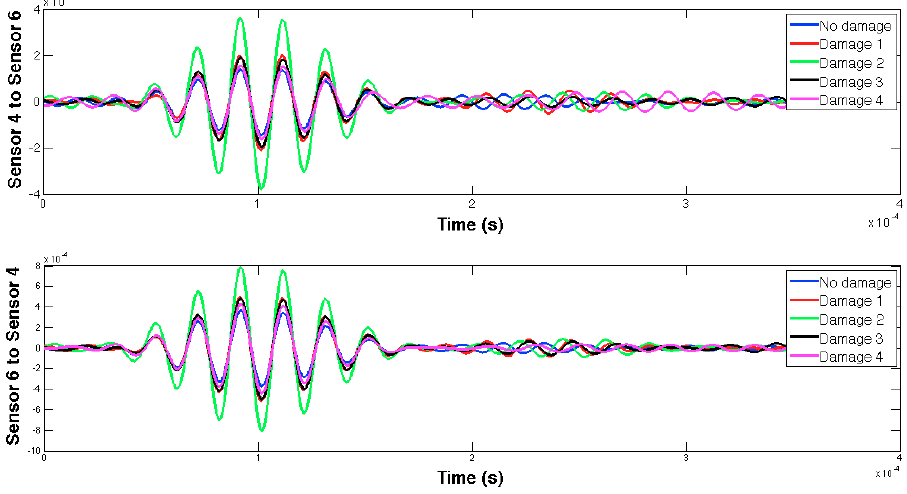
Figure 23. EMPD at 50 kHz. Tone-burst sent and measured between sensors 4 and 6.